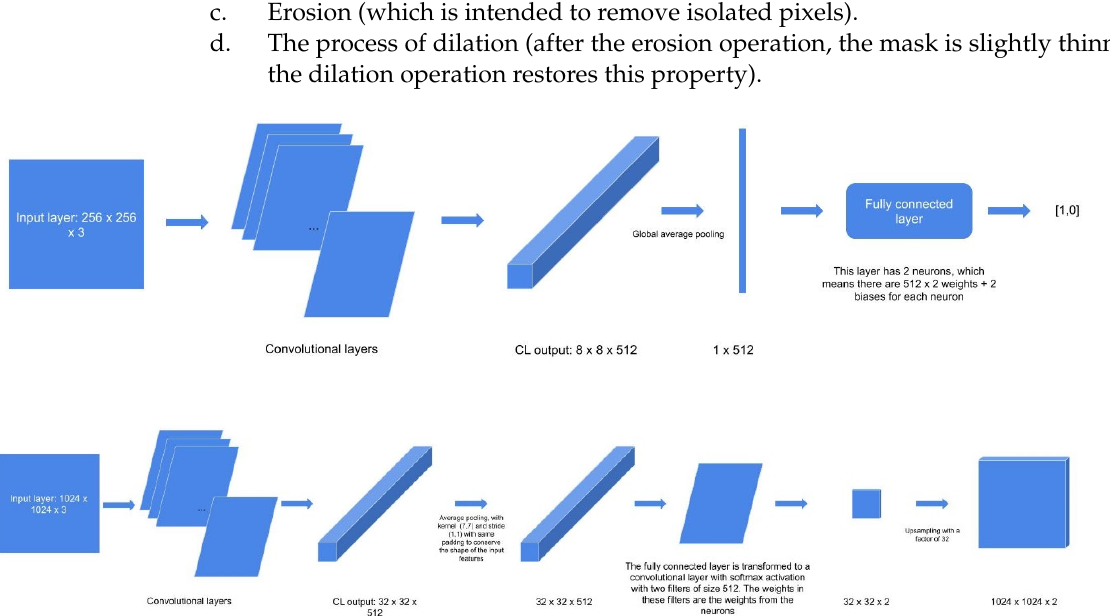
Figure 4. Expansion of the MobileNet model.